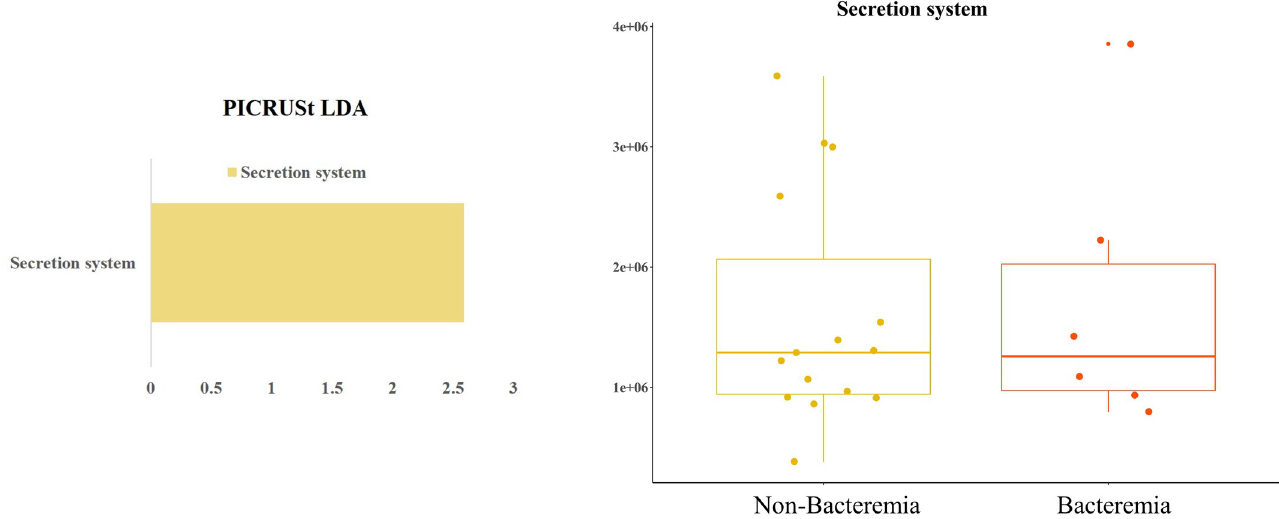
Fig 5. Differentially abundant gene functions between the non-bacteremic and bacteremic groups in the biofilm microbiome in extracorporeal membrane oxygenator catheters (ECMO). (A) Gene functions enriched in the non-bacteremic group are colored green. The box plot represents the predicted value of the secretion system. Functional categories of genes on the ECMO catheters were predicted using Phylogenetic Investigation of Communities by Reconstruction of Unobserved States. Differentially abundant functions were identified using linear discriminant analysis coupled with effect size measurements.